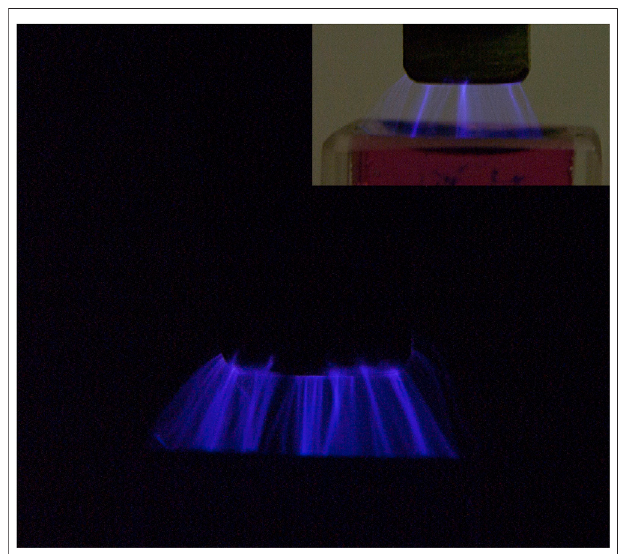
FIGURE 2 | Photograph of the direct piezo-discharge CAP liquid media surface